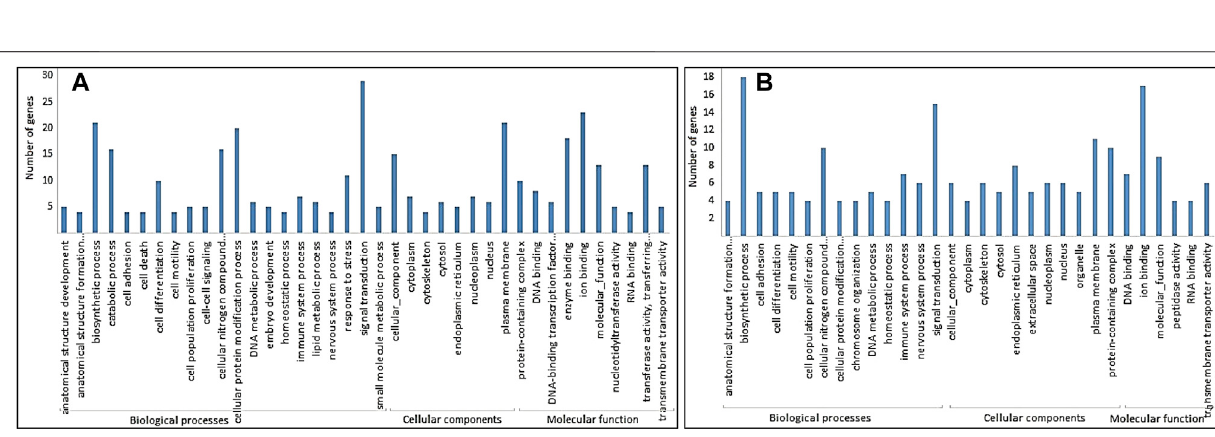
Frontiers in Genetics |